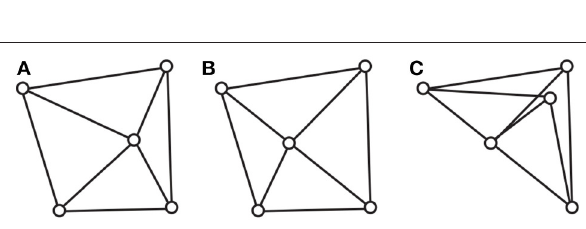
FIGURE 7 | globally rigid framework (A) , which loses this property in the nongeneric configuration (B) , where three nodes are aligned on a diagonal. For the latter framework the configuration (C) is also possible.